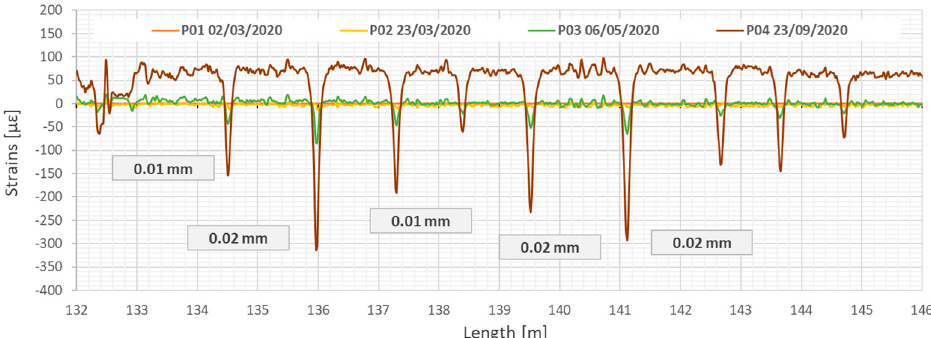
Figure 24. Strain profiles measured by the monolithic sensor (T) along the test section showing the primary discontinuities in the concrete collector closing during strengthening process. Example section from 132 to 146 m. Measurement P01—after installation of GRP panels, P02—during grout injection, P03—after completed grout injection, P04—after filling the collector with sewage [58].